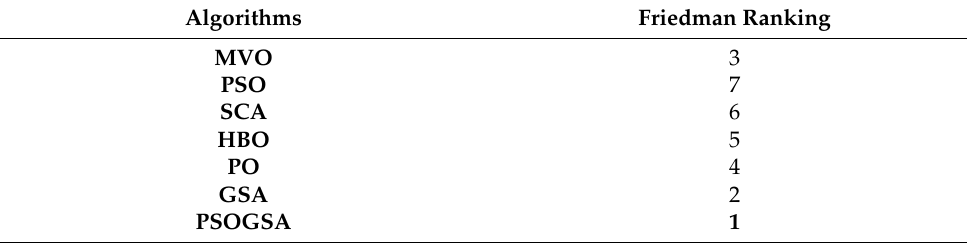
Table 11. Friedman ranking test’s statistical result for the monocrystalline PV Cell. Algorithms Friedman Ranking